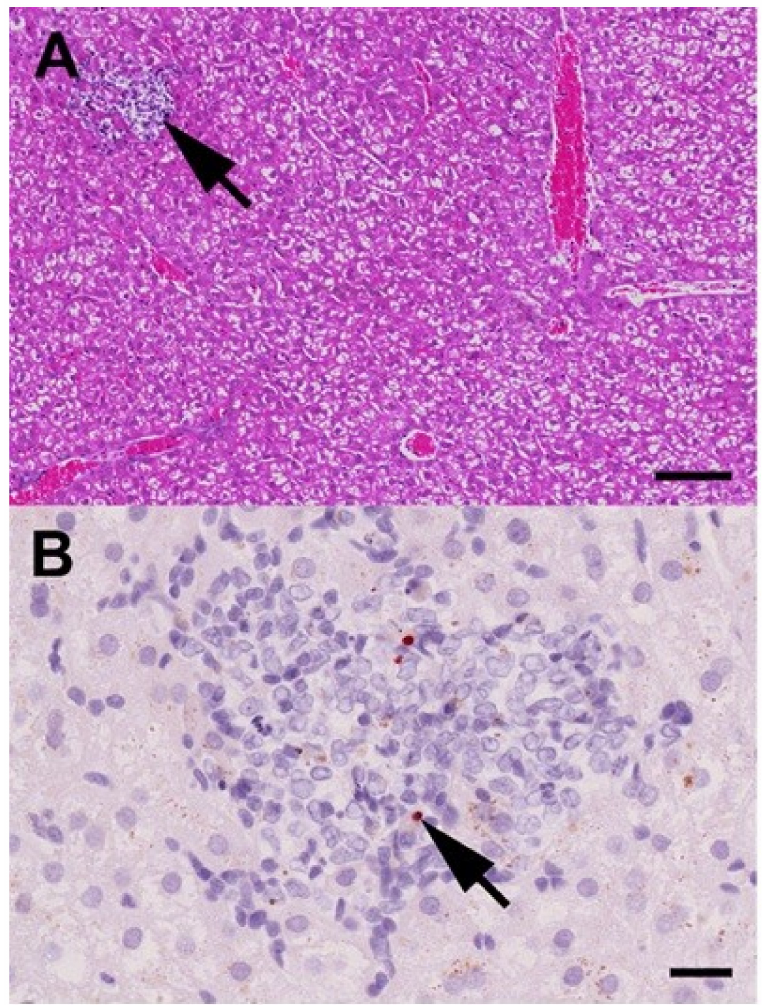
Figure 3. Histopathological findings in the liver of a Rousettus aegyptiacus fruit bat immunized with the MP-12 vaccine strain at day seven post immunization. ( A ) Histopathology shows few, randomly distributed foci of hepatocellular necrosis and loss with macrophage and lymphocyte infiltration (arrow). Furthermore, the hepatocytes display moderate, coalescing to diffuse, floccular cytoplasmic vacuolization, interpreted as a species-specific, relatively high level of glycogen storage. Hematoxylin-eosin. Bar = 100 µ m; ( B ) Immunohistochemistry for Rift Valley fever phlebovirus (RVFV) Gc antigen reveals minor amounts of intra- and extracellular, strongly immunoreactive granula within the lesions (arrow), interpreted as debris remaining after virus-induced hepatocellular death. Immunohistochemistry, monoclonal mouse anti-RVFV Gc-protein antibody, avidin-biotin-peroxidase-complex method, 3-amino-9-ethyl-carbazol chromogen (red), hematoxylin counterstain (blue). Bar = 20 µ